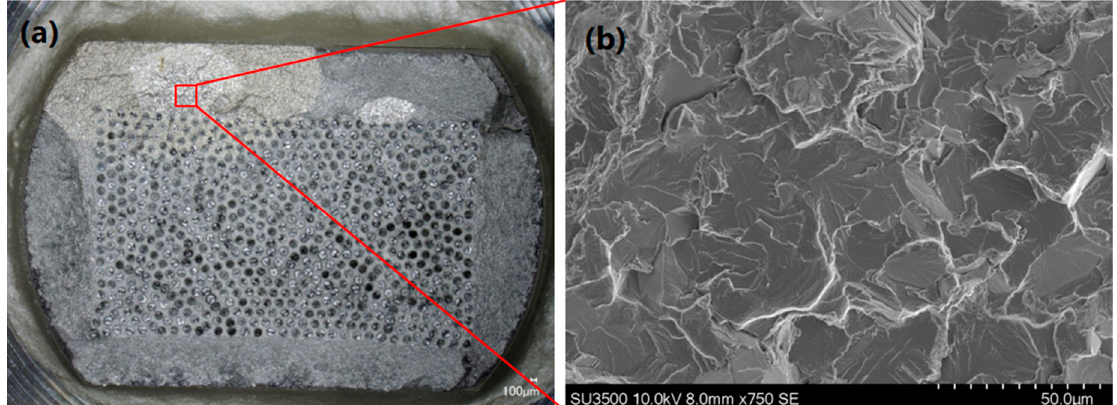
Figure 11. Early failure in IP 1000 MPa specimen shown to be related to a zone of macrotexture indicated by extensive facet formation. ( a ) Optical microscopy of the full fracture surface; ( b ) SEM image of flat faceted area at the crack initiation site.